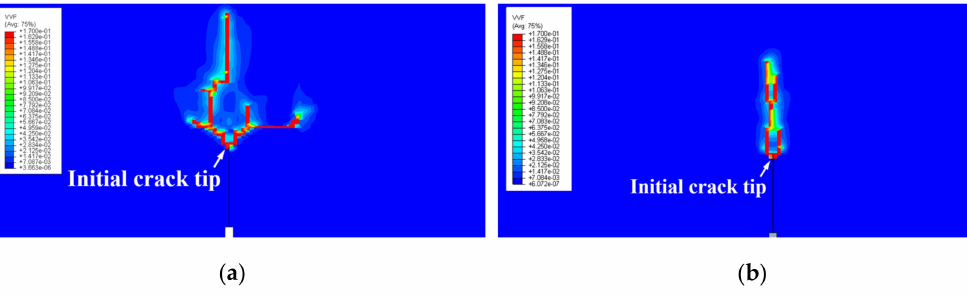
Figure 11. The crack propagation paths of all the third crack-branching models.